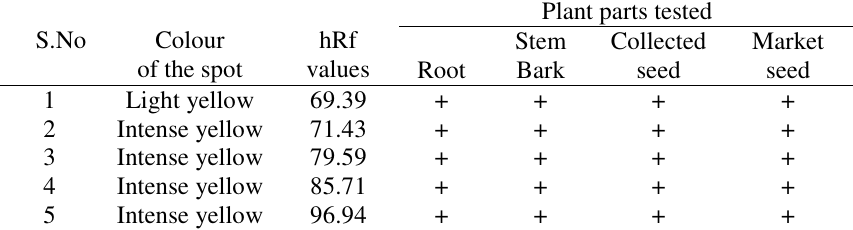
Table 7 . Qualitative separation of saponins of